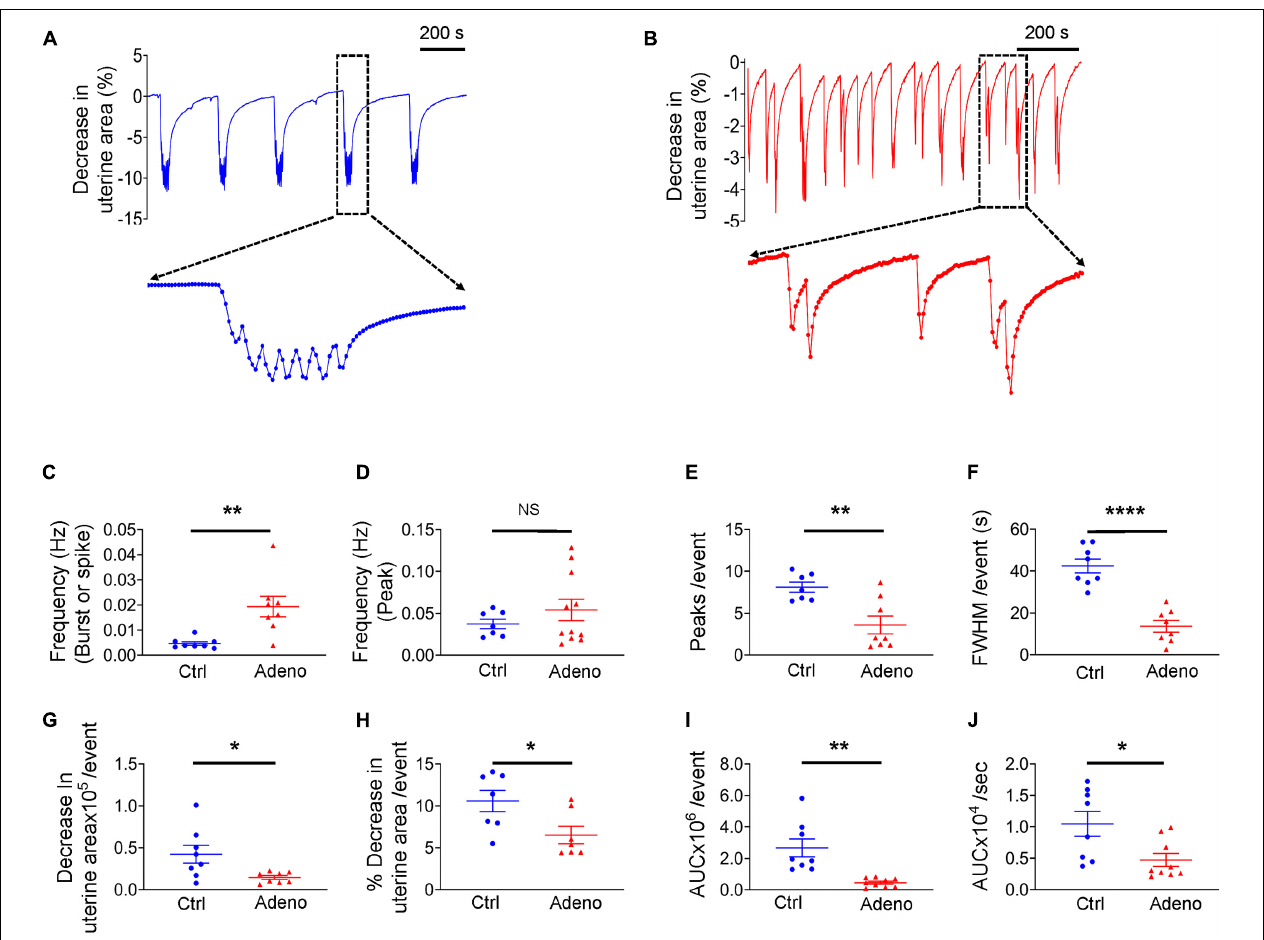
FIGURE 5 | Changes in uterine peristalsis in adult adenomyotic mice. (A) Typical uterine peristalsis events in postnatal day (PND) 55 mice after treatment with the vehicle for tamoxifen (Ctrl). A burst event, marked with the dotted line box, is shown in an expanded time scale. (B) Typical uterine peristalsis events in PND55 mice after with tamoxifen (Adeno). Three events in the dotted line box are shown in an expanded time scale. (C) Frequency comparison between Ctrl mice and Adeno mice at PND55 when a burst or a spike was counted as one event (the same convention applied to panels E–J ). (D) Frequency comparison between Ctrl mice and Adeno mice at PND55 when every peak was counted as one event. (E) Comparison of peak numbers/event between two group mice. (F) Full width at half maximum (FWHM)/event in two group mice. (G) Changes in uterine slice absolute areas/event in two group mice. (H) Changes in slice relative areas/event in two group mice. (I) Area under the curve (AUC)/event in two group mice. (J) Contraction intensity (AUC × Frequency) comparison between Ctrl and Adeno mice. Note that each data point in panels (C–J) is an average value from multiple slices in a mouse, and each slice was recorded for ∼ 1 h. N.S., no statistical significance, * P < 0.05, ** P < 0.01, **** P < 0.0001 with unpaired Student’s t -test ( N = 8 Ctrl mice (20–24 slices) and 8–11 Adeno mice (24–28 slices) for panels